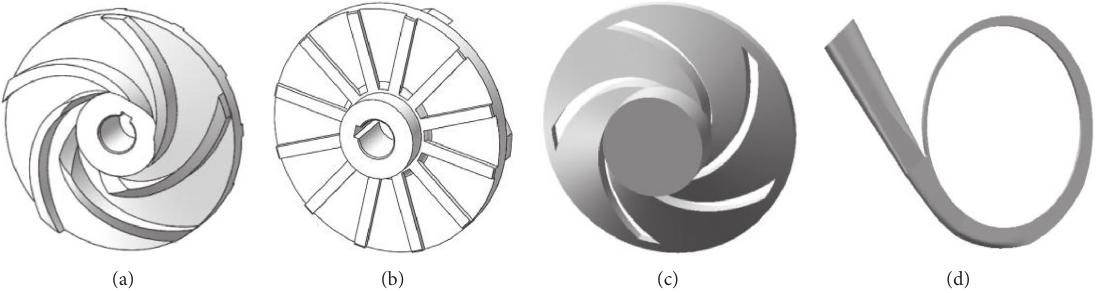
Figure 3: Three-dimensional design of the impeller. (a) Front view of the impeller model. (b) Back view of the impeller model. (c)Impeller water model. (d)Volute water model.